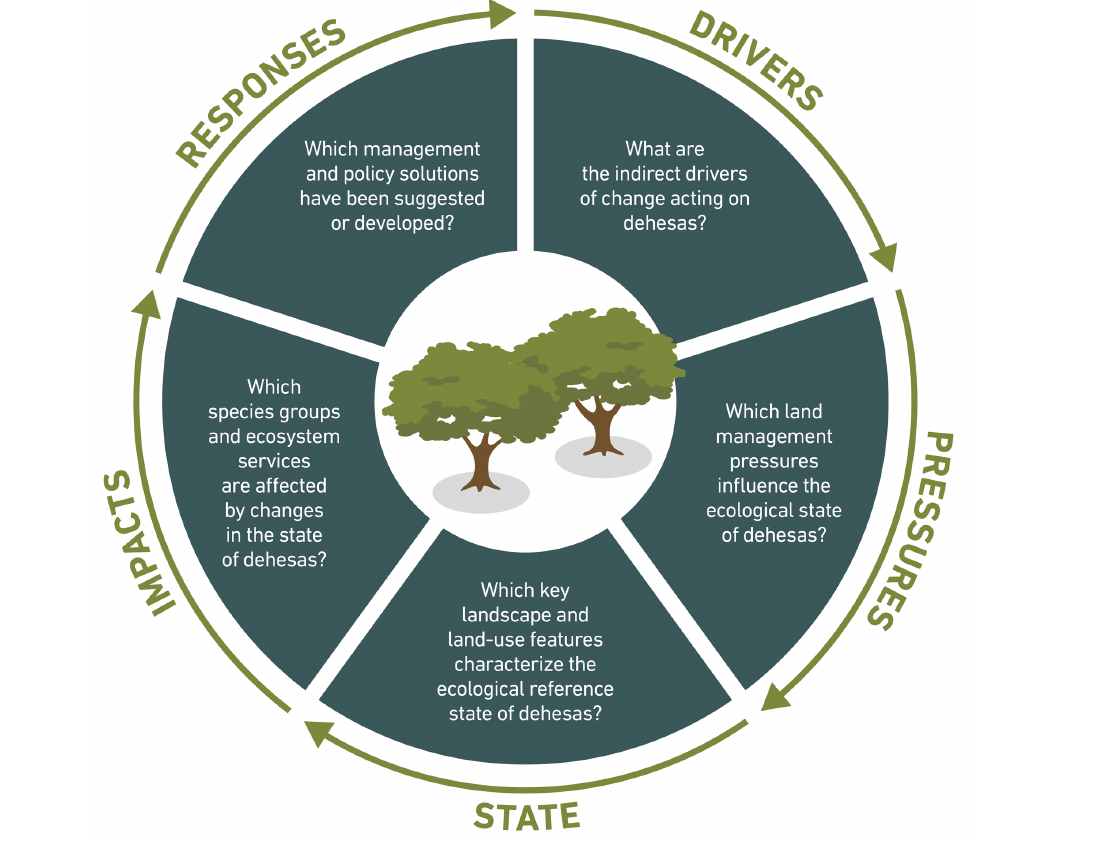
Fig. 1 . Research questions organized within the Drivers - Pressures - State - Impacts - Responses (DPSIR) framework.